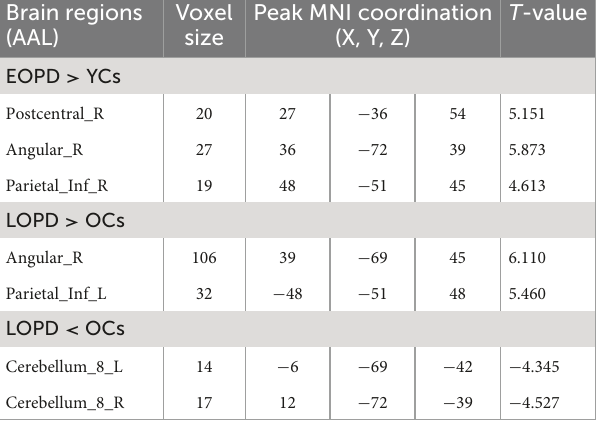
TABLE 2 Brain regions with altered intra-network functional connectivity in EOPD and